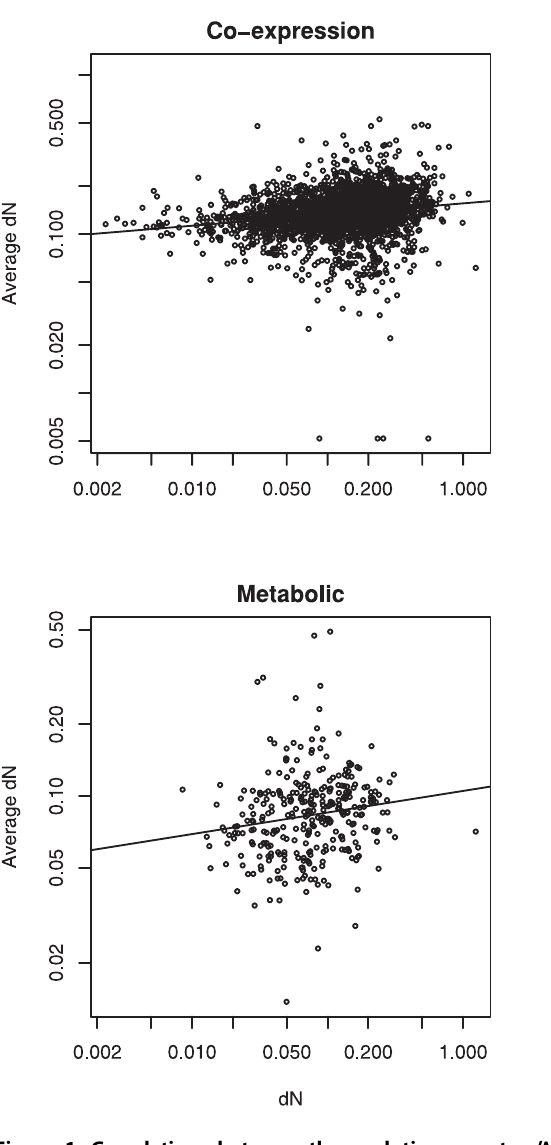
Figure 1. Correlations between the evolutionary rate dN of focal proteins and the average rate of their network neighbours neighbours for four different types of interaction networks.